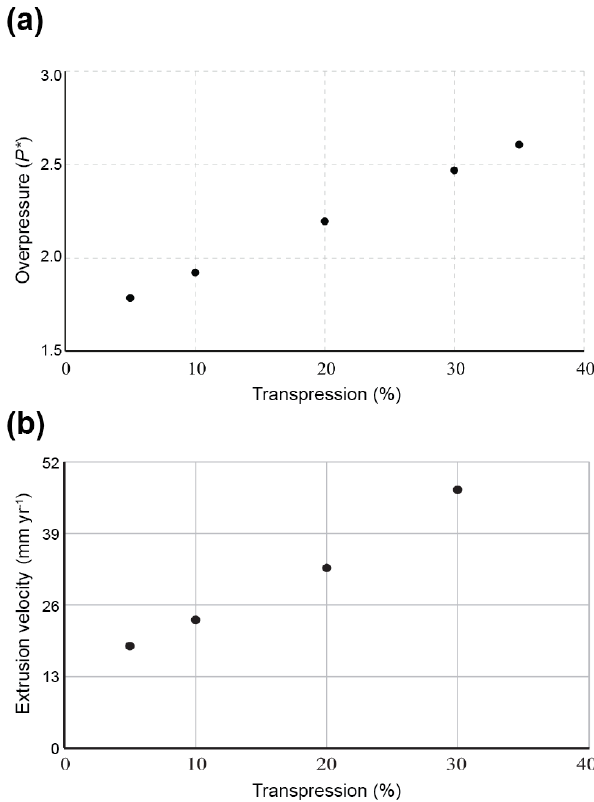
Figure 6. Graphs showing the linear dependence of overpressure (TOP) (a) and extrusion velocity (b) on transpression.